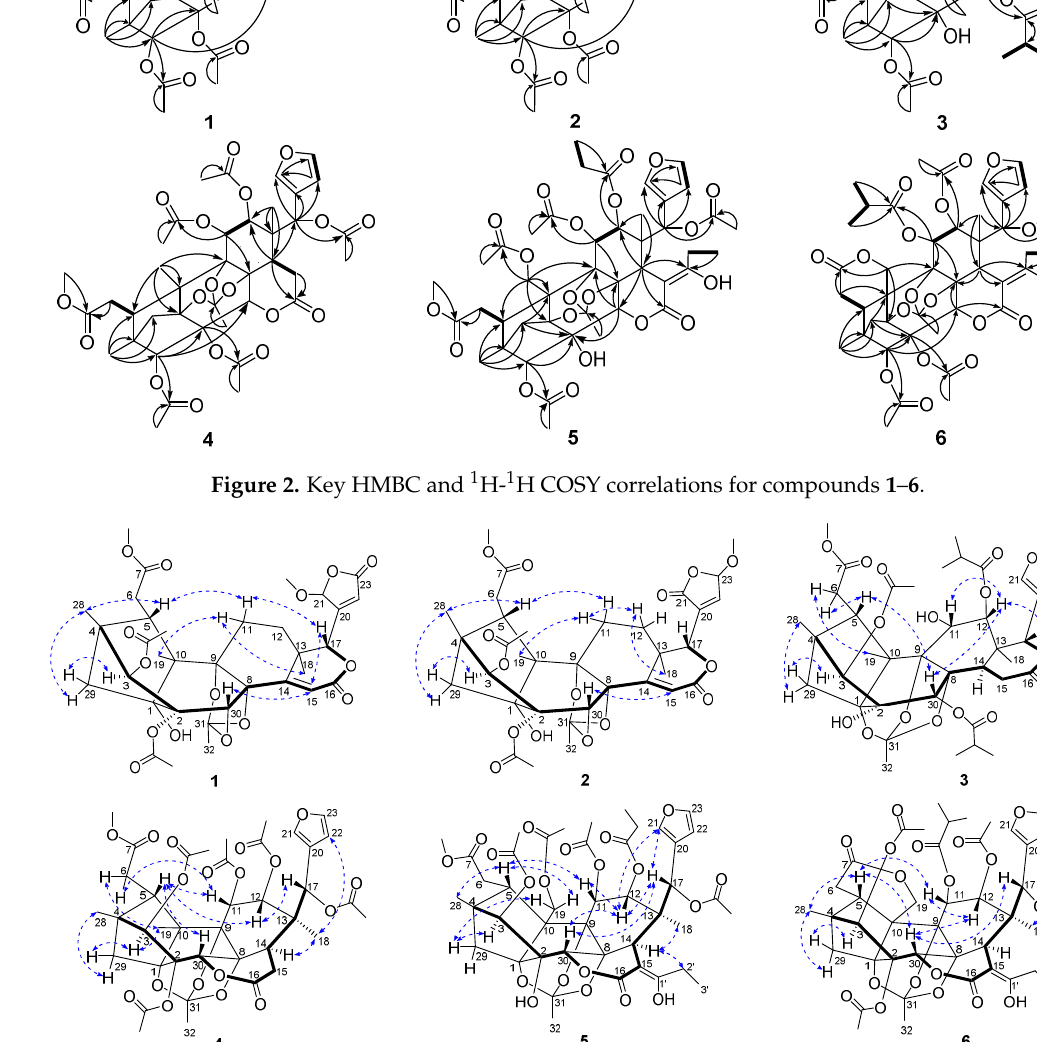
Figure 3. Key ROESY correlations for compounds 1 – 6 .